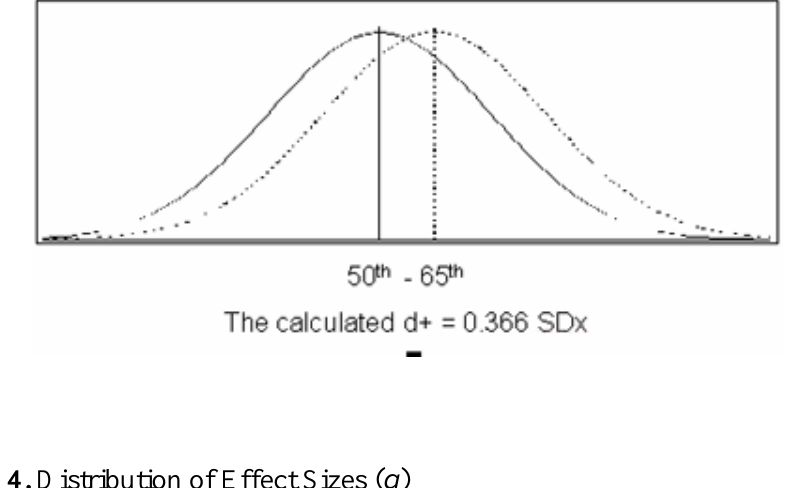
Figure 4. Distribution of Effect Sizes ( g